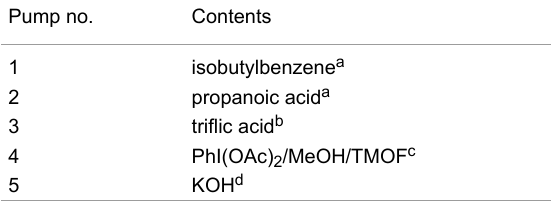
Table 1: Contents of the automated syringe pumps controlled by the automated synthesis robot. Pump